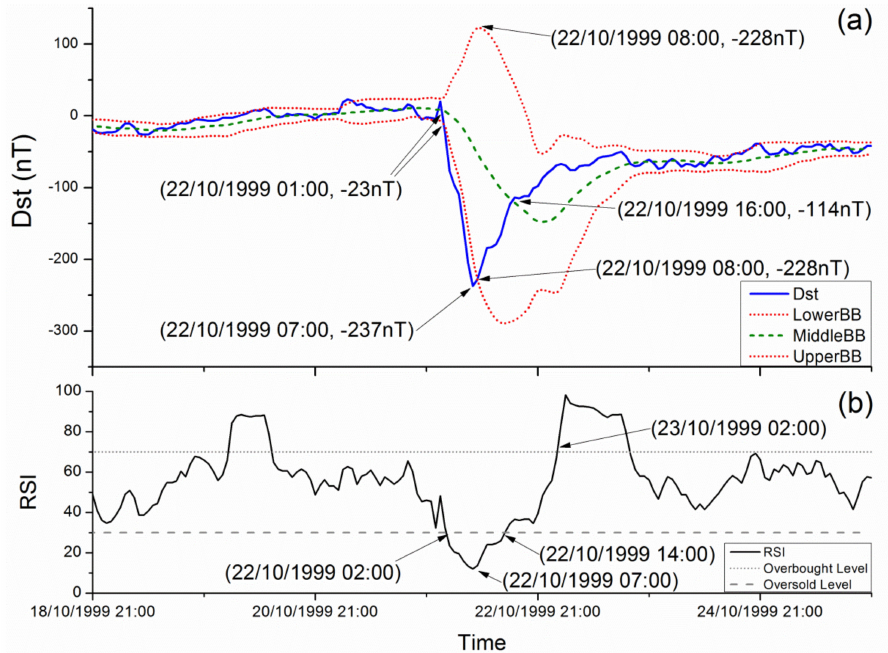
Figure 3. The evolution of an MS which occurred in 1999 in terms of ( a ) the SMA and Bollinger bands, and ( b ) the RSI indicator. The analyses results for a seven-day period from 18 October 1999 21:00 (UT) to 25 October 1999 21:00 (UT) are presented. The exact time and D st value for which specific features were found are marked on the figure using